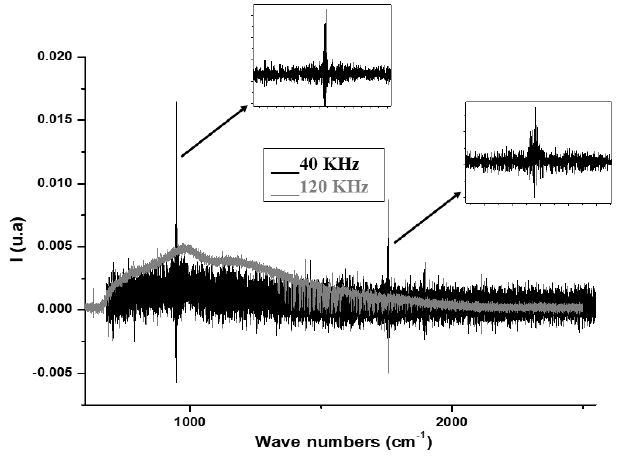
Figure 6. Spectra of the internal blackbody of CHRIS with scanner velocities of 40KHz (black) and 120KHz (light